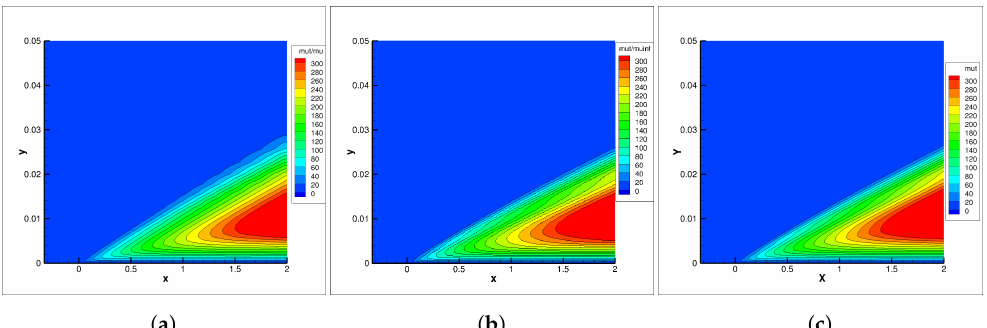
Figure 4. Contours of µ T / µ ∞ for flat plate using Shear Stress Transport turbulence‘model: ( a ) UNS3D-SEQ, ( b ) UNS3D-PAR, and ( c ) FUN3D [20].